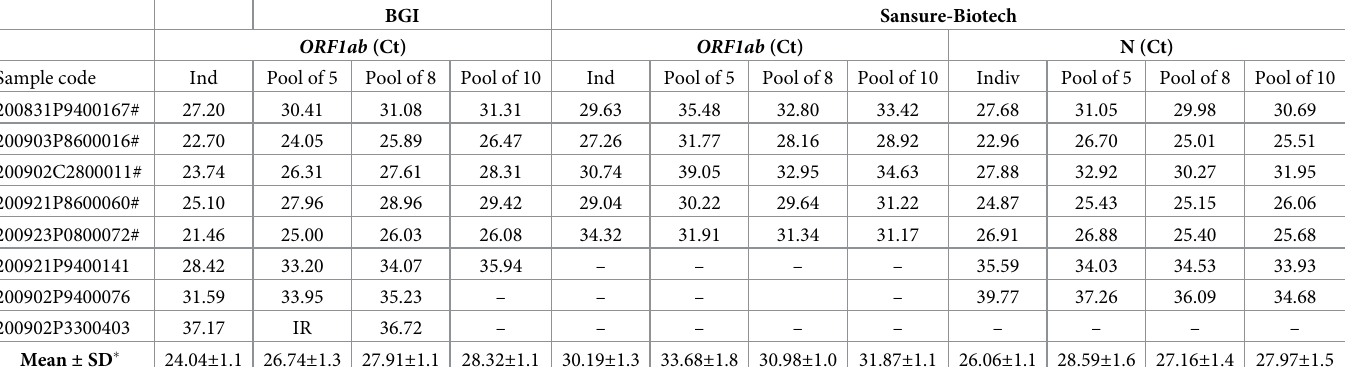
Table 3. Range of cycle threshold (Ct) values of individual (retest) and pooled samples using BGI and Sansure-Biotech methods.